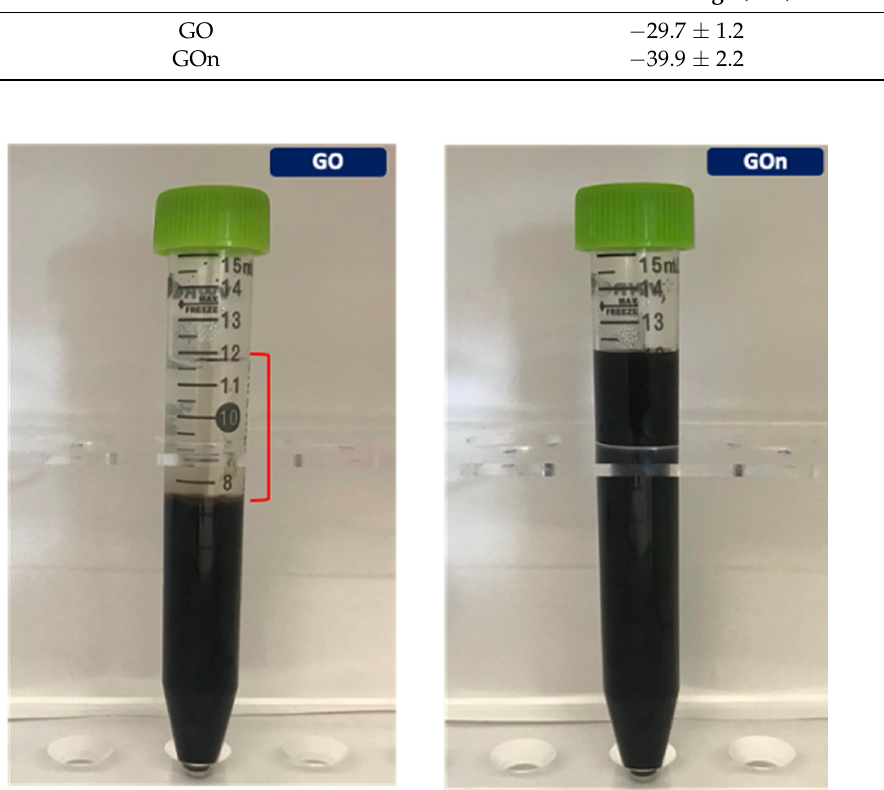
Figure 5. GO ( left ) and GOn ( right ) dispersions after 6 months storage at rest. The red bracket on the left image shows the height of clear supernatant liquid formed in the GO dispersion. Generally, smaller average particle size and coefficient of variation (ratio of the stan- dard deviation to the mean particle size) together with lower zeta potential values have been identified as critical parameters to demonstrate dispersion stability of GO materials, thus favoring the production of homogeneous GO dispersions at larger scales and with improved product quality [16,17]. Overall, high-power ultrasonication enabled the produc- tion of GO nanosheets with smaller average particle size (99 versus 287 nm for centrifuged GO) and slightly lower smaller coefficient of variation (43% versus 48%). Additionally,